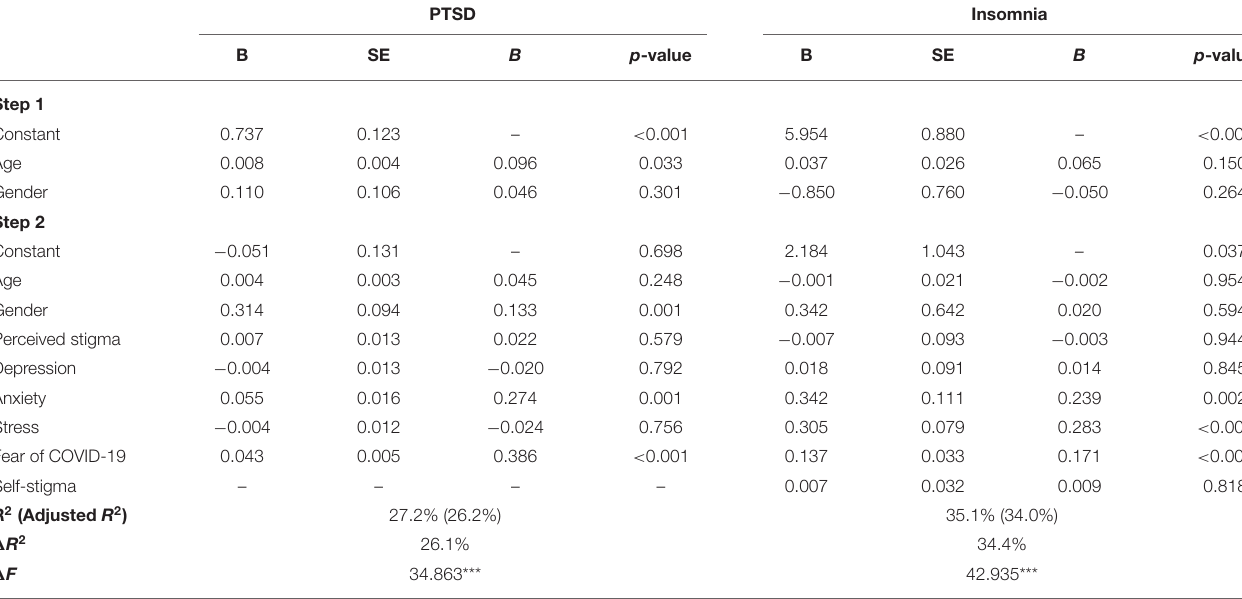
TABLE 4 | Predictive factors of post-traumatic stress disorder (PTSD) and Insomnia †